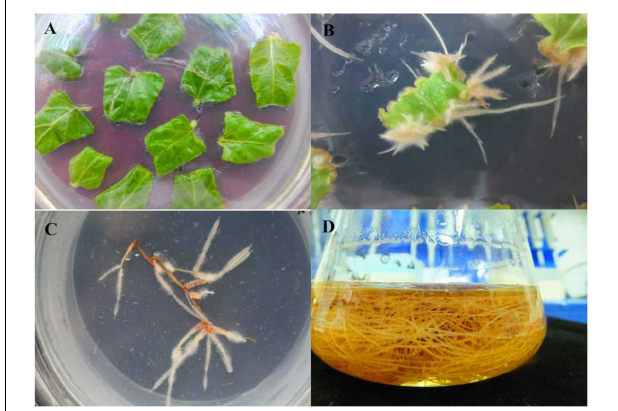
FIGURE 4 | Generation of transgenic hairy root of S. miltiorrhiza. (A) S. miltiorrhiza explants on 1 / 2 MS medium. (B) The growing hairy root on the infected S. miltiorrhiza explants. (C) Monoclone of hairy root. (D) Hairy roots culture in 1 / 2 MS